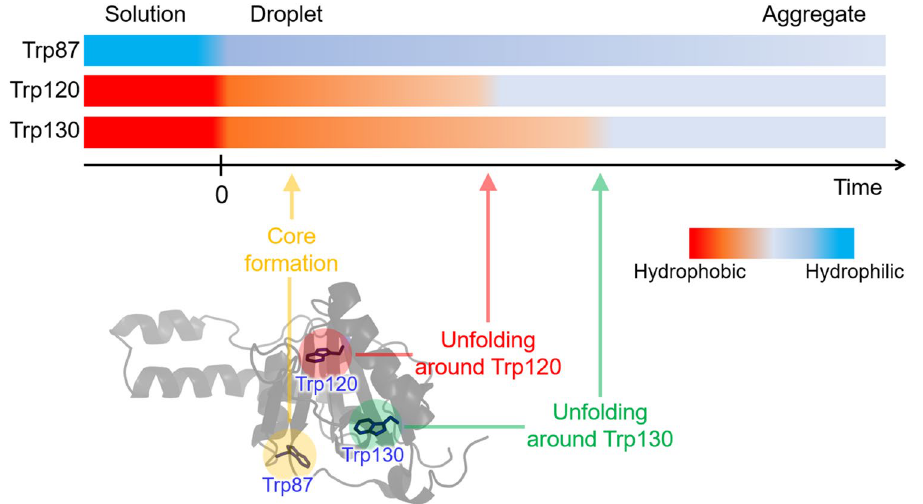
Figure 6. Structural changes in Q28 inside droplets and concomitant changes in the environment around the Trp residues. Horizontal bars indicated by Trp87, Trp120, and Trp130 show temporal changes in hydrophilicity around these Trp residues. LLPS occurs at time 0. The structure of JD and the arrangement of Trp residues are shown at the